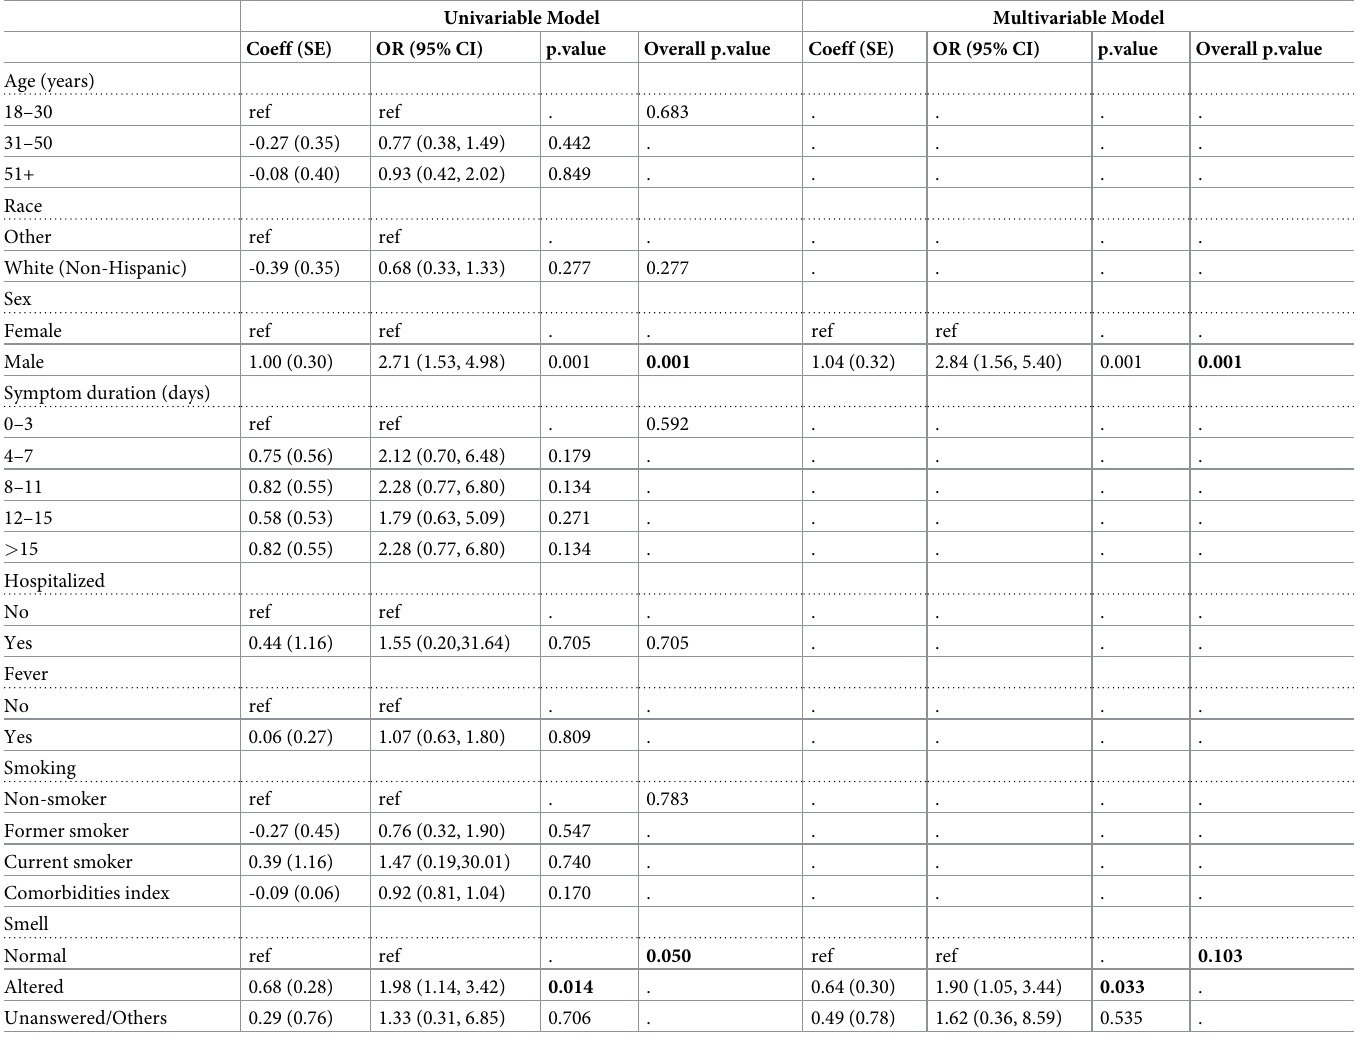
Table 3. Univariable and multivariable logistic models using SMELL as the main predictor. Univariable Model Multivariable Model OR (95% CI) p.value Overall p.value Coeff (SE) OR (95% CI) p.value Overall